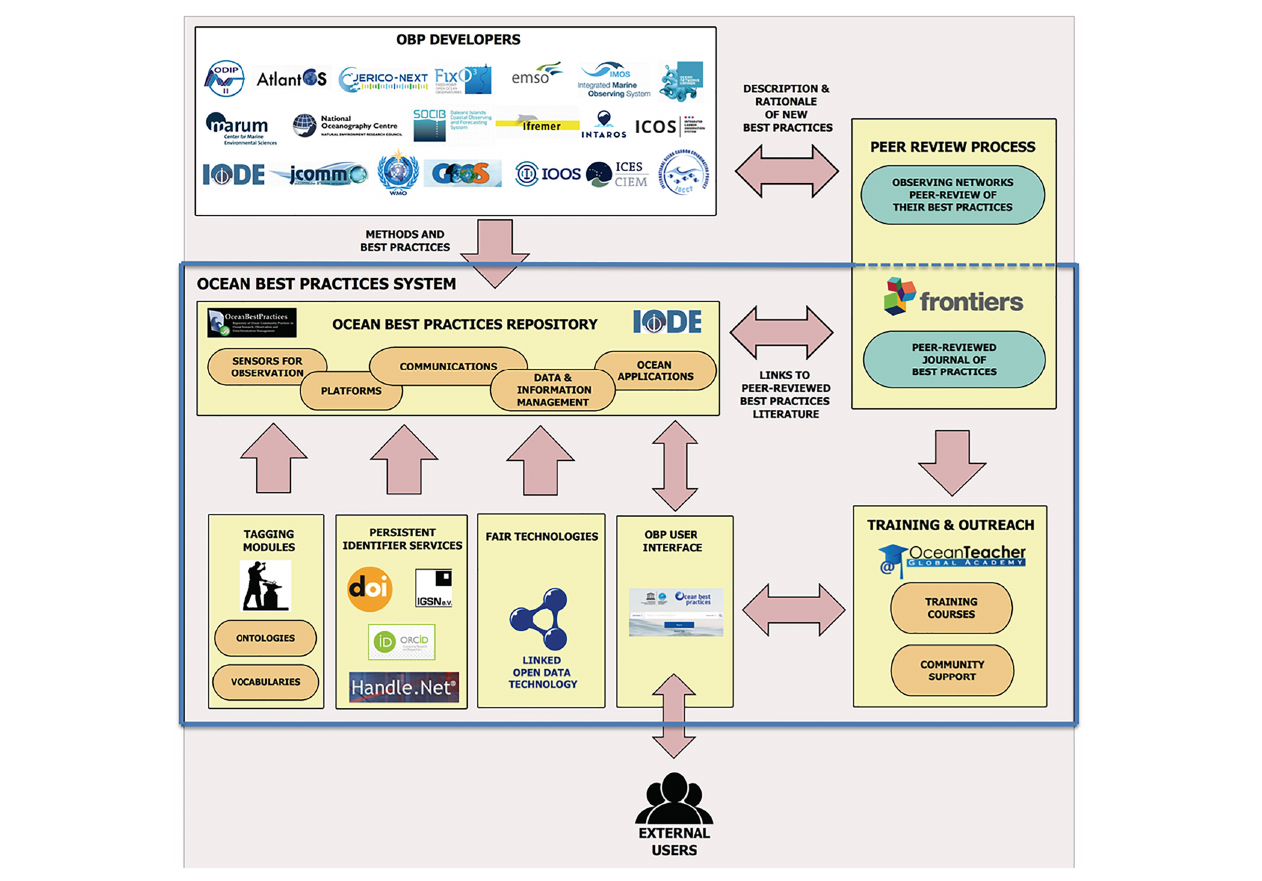
FIGURE 2 | OBPS structure (large box across middle of figure), core technologies (along the bottom of the box), and best practice provider organizations (in the box at top). Training is shown at the bottom